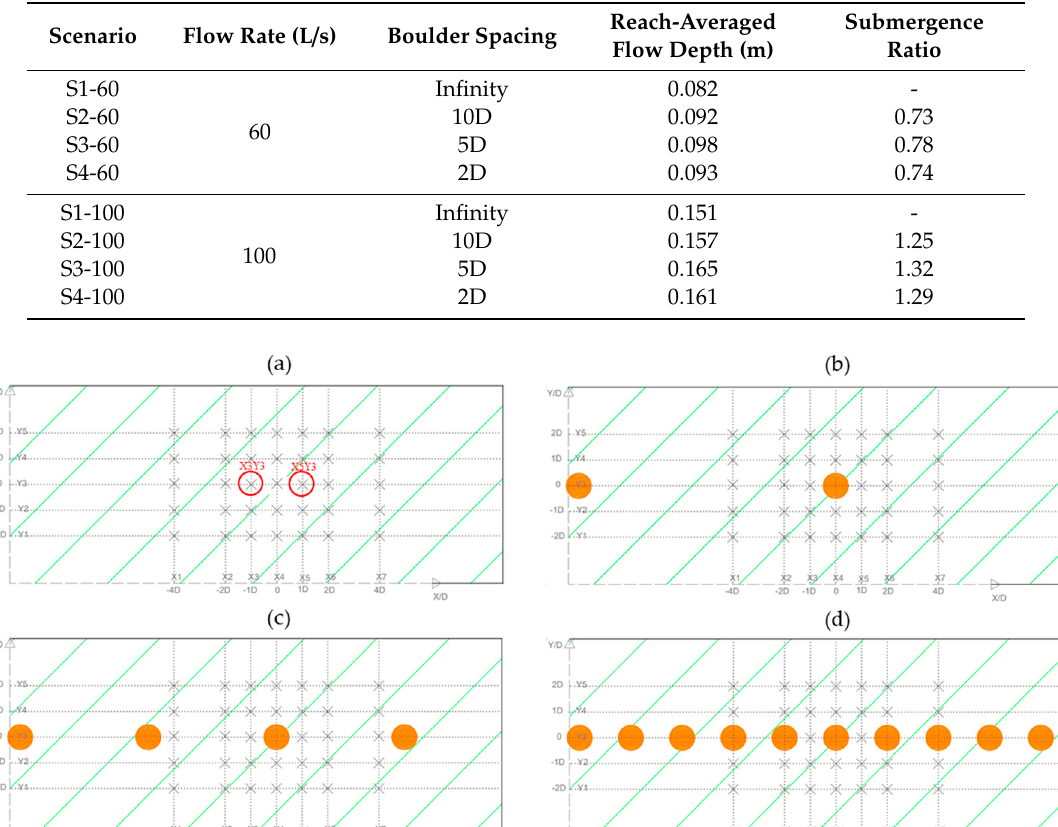
Table 1. Characteristics of the experiments.